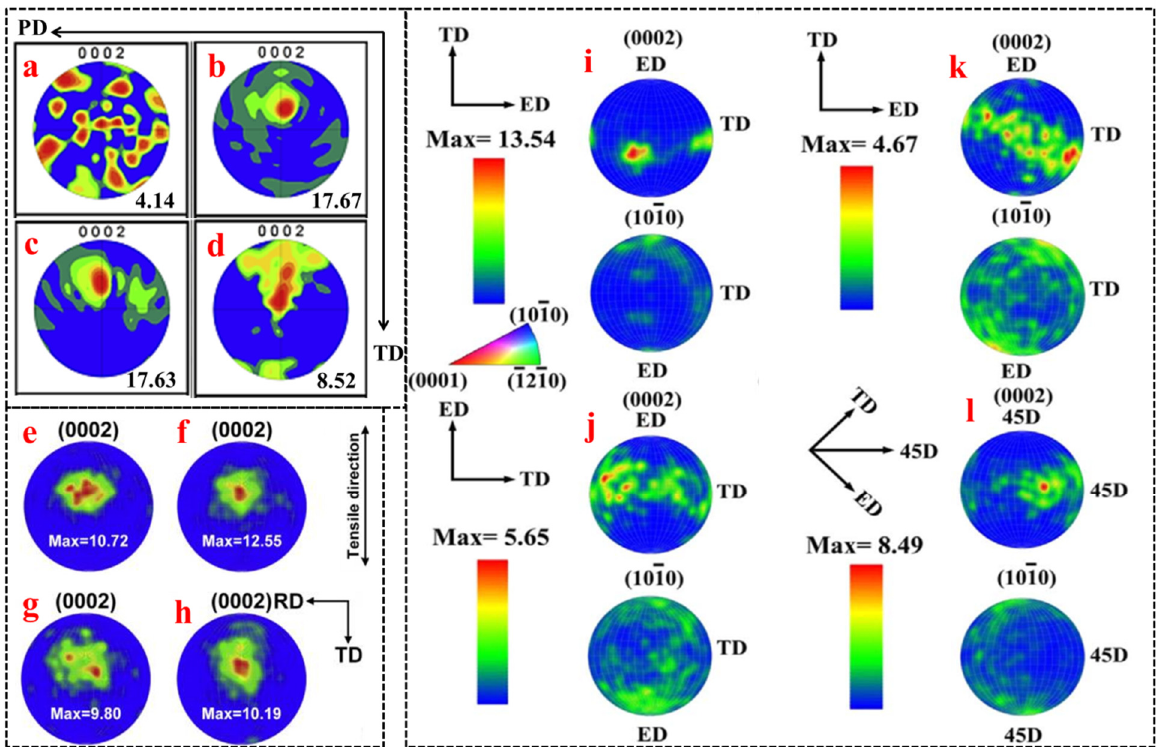
Figure 6. Pole figure analysis of different alloys: ( a ) QE22 Mg alloy in as received form; ( b ) as processed form; ( c ) under 350 °C at a strain rate of 0.01 s − 1 ; ( d ) under 350 °C at a strain rate of 0.003 s − 1 [39]; ( e ) pole figure of Mg ‐ Al ‐ Zn ‐ Sn at temper ‐ ature 300 °C and a strain of~50%; ( f ) at a strain of~100%; ( g ) at a strain of 200%; ( h ) at a strain of~300% [45]; ( i ) grip section of ED specimen of ZK60 Mg alloy; ( j ) gauge section of TD; ( k ) gauge section of ED; ( l ) gauge section of 45D ‐ sample [26].